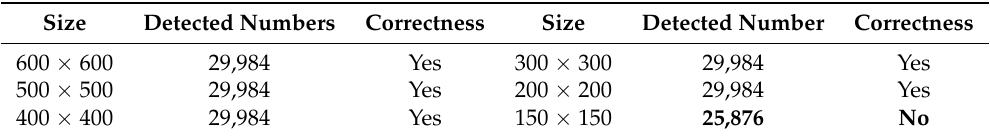
Table 7. Quality of decoded bar-codes affected by scaling of